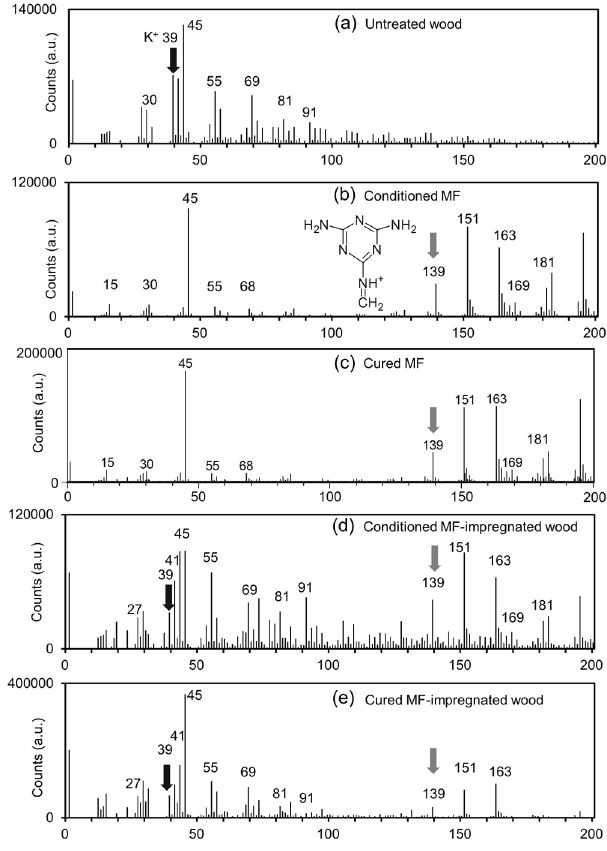
Figure 2. Positive ion TOF-SIMS spectra obtained from ( a ) untreated wood, ( b ) conditioned MF at RH of 43%, ( c ) cured MF, ( d ) conditioned MF-impregnated wood at RH of 43%, and ( e ) cured MF-impregnated wood. The characteristic peaks of K + at m/z 39 and the fragment MF ion at m/z 139 are shown. The structure of the fragment obtained from MF at m/z 139 is also inset in ( b